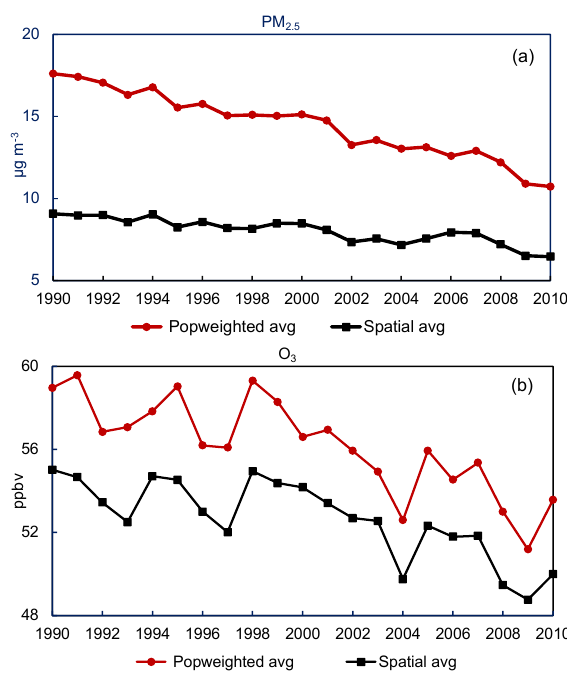
Figure 2. Population-weighted average (Popweighted avg) and spatial average over CONUS land areas of annual average PM 2 . 5 (a) and summertime average of 1h daily maximum O 3 (b) concentration from 1990 to 2010. Population-weighted av- erage concentrations are based on population in each year. Using the same population in each year yields estimates of population- weighted concentrations that are only slightly different (not